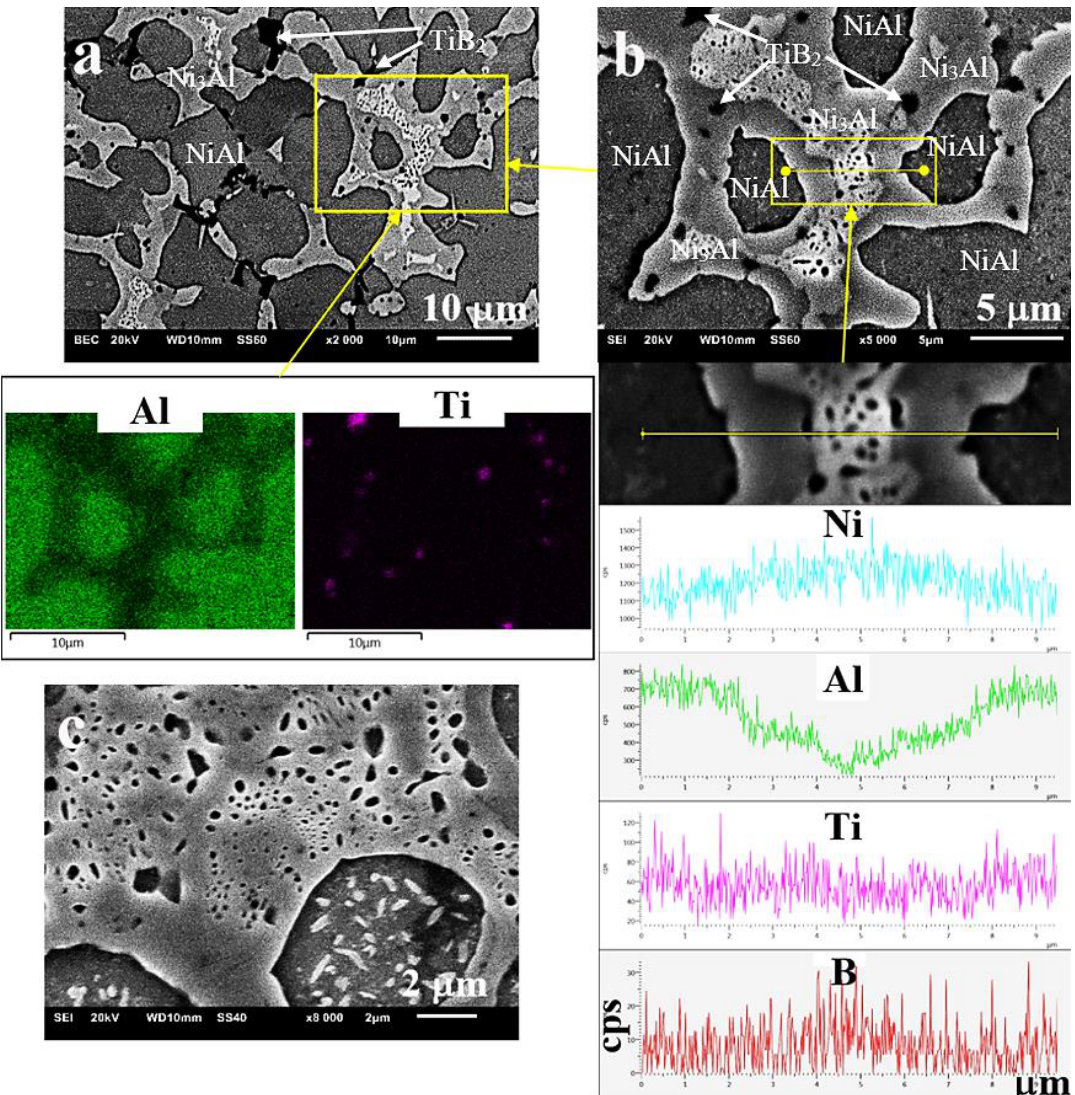
Figure 5. Microstructure of the NiAl / TiB 2 composite at various magnifications: ( a ) BSE micrographs, ( b ) EDS analysis of the distribution of individual microstructural constituents, ( c ) “islands” of the residual Widmanstätten structure.